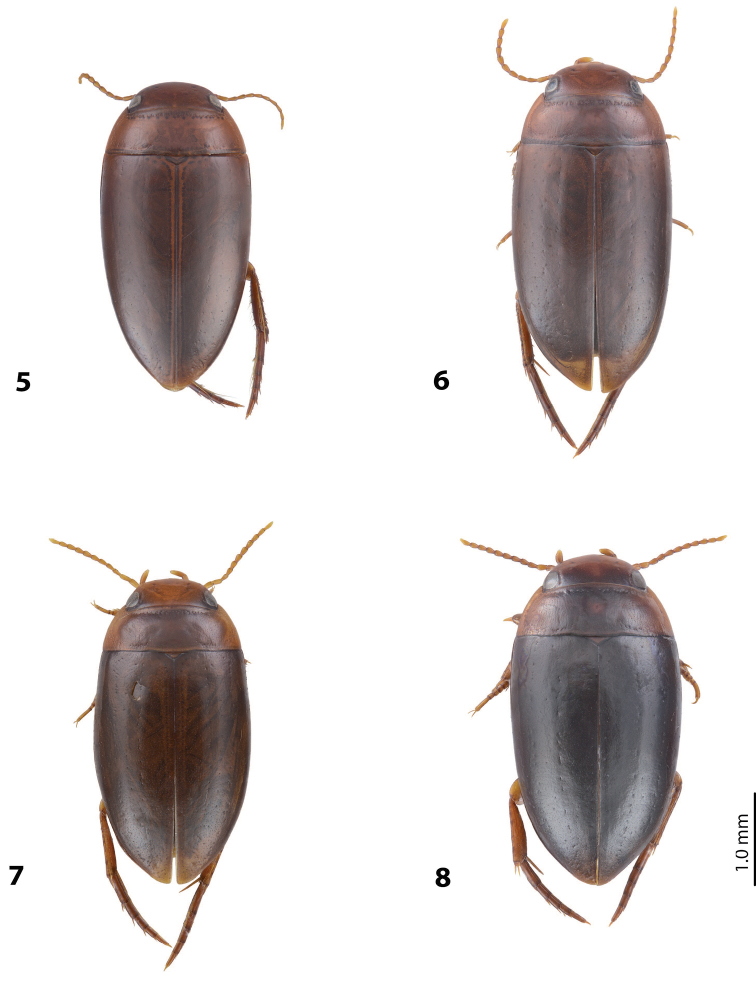
Habitus and coloration 5Exocelinamesseri (Balke, 1999) 6E.keki sp. n. 7E.pseudofume sp. n. 8E.sima sp. n.